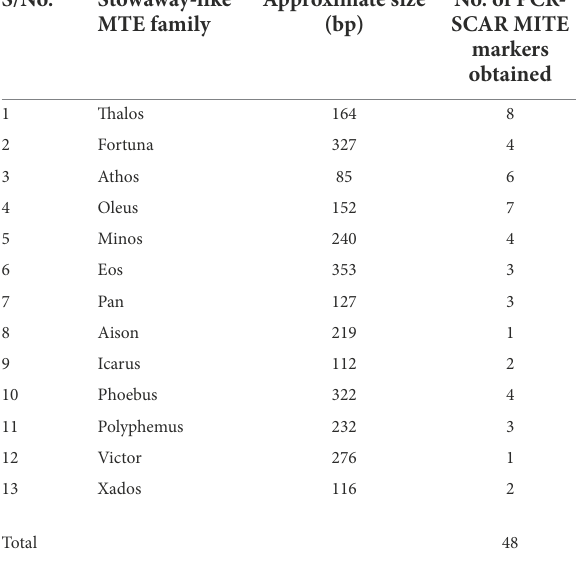
TABLE 2 Number of PCR–SCAR MITE markers obtained from 13 Stowaway-like MITE families.